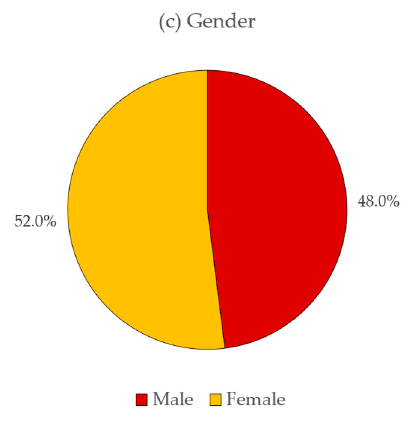
Figure 6. Characterization of the sample: ( a ) age; ( b ) qualifications; and ( c ) gender.